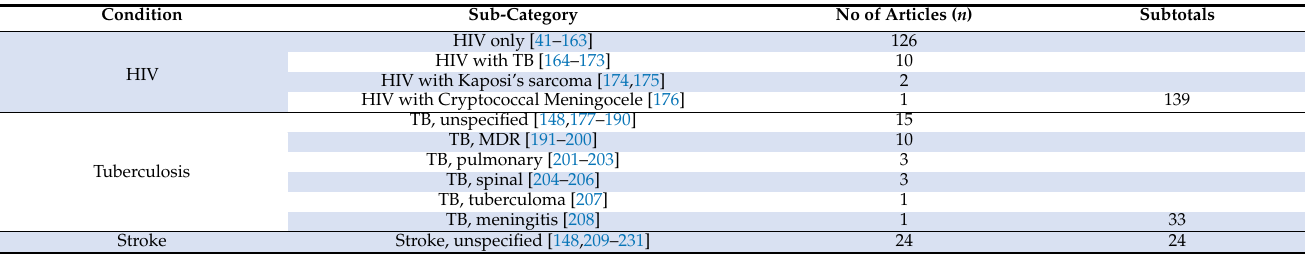
Table 1. Number of articles according to the top ten health conditions contributing to greatest disability in South Africa.